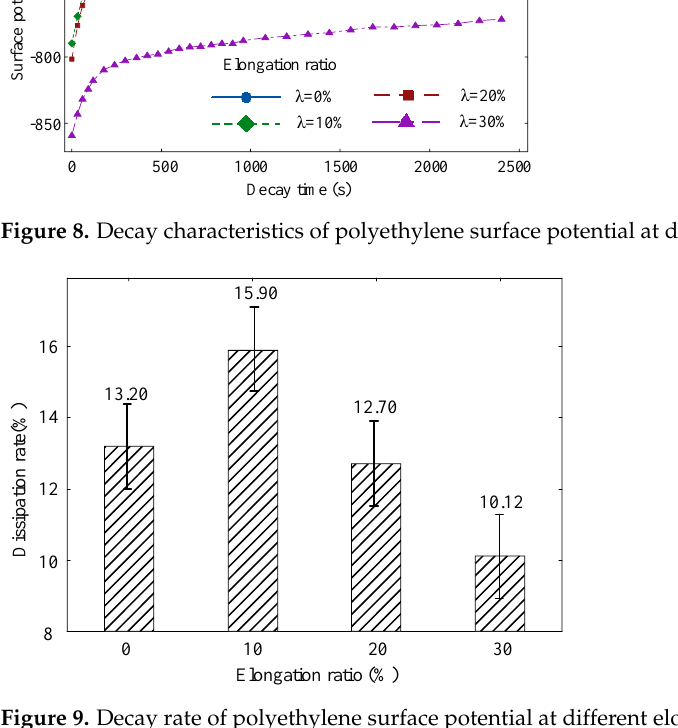
Figure 9. Decay rate of polyethylene surface potential at different elongation ratios.